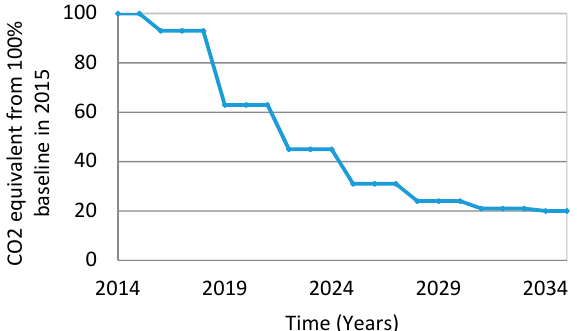
Figure 1. Expected phasing down process according to EU regulation 517 / 2014.